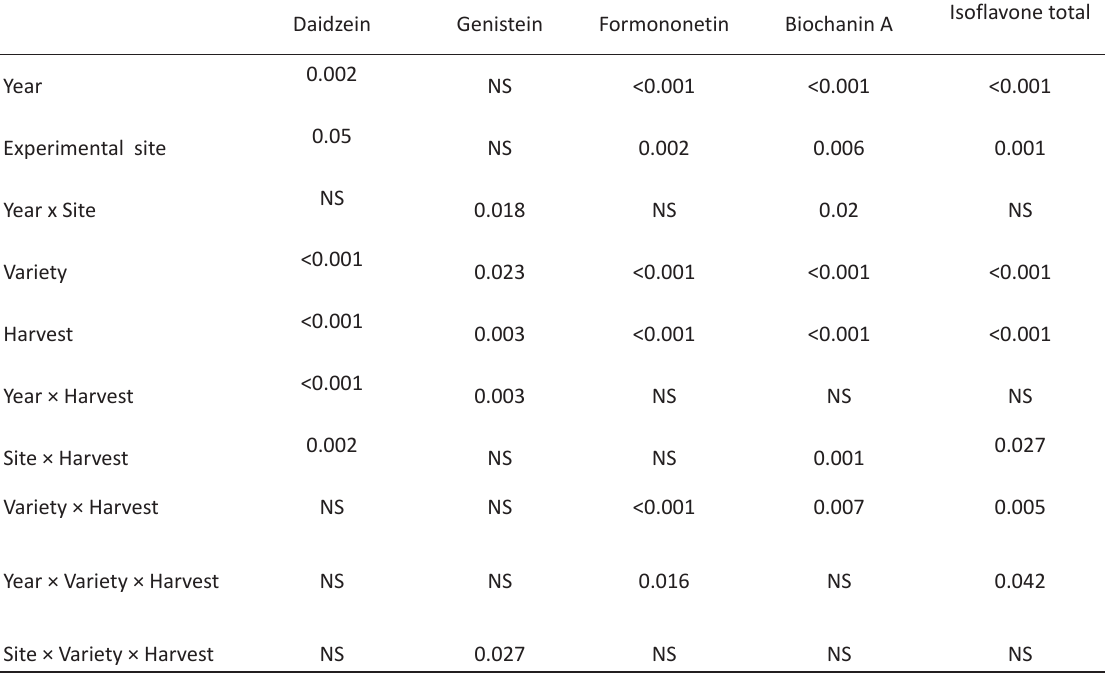
Table 3. p -values from the analysis of variance of the isoflavone concentration of four red clover varieties grown for two years at two experimental sites and harvested twice during growing